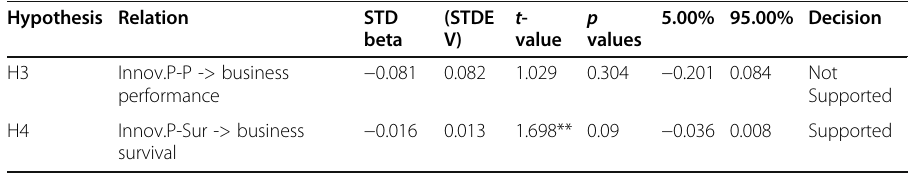
Table 6 Moderating